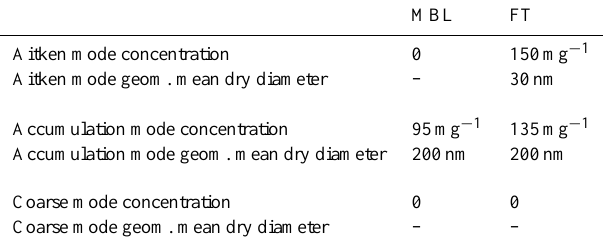
Table 1. Initial aerosol properties in the marine boundary layer (MBL) and free troposphere (FT).